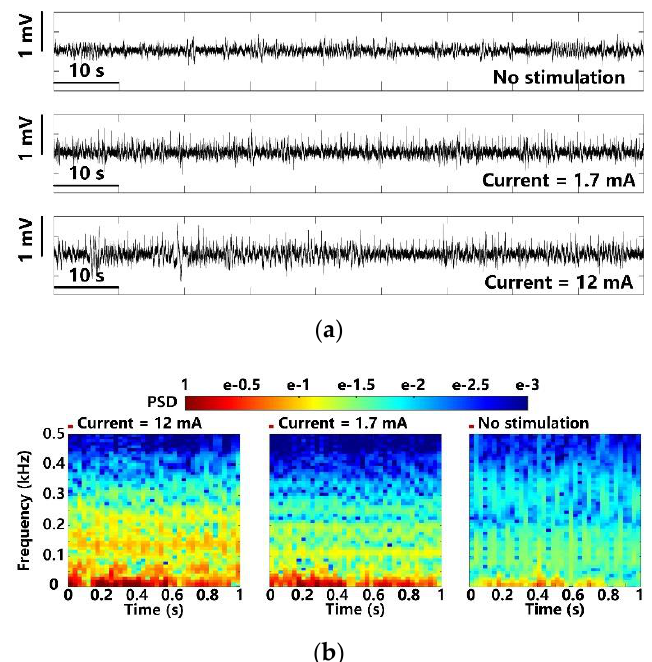
Figure 13. LFP analysis in terms of ( a ) amplitude variation and ( b ) normalized PSD with maximum and minimum optical stimulation.